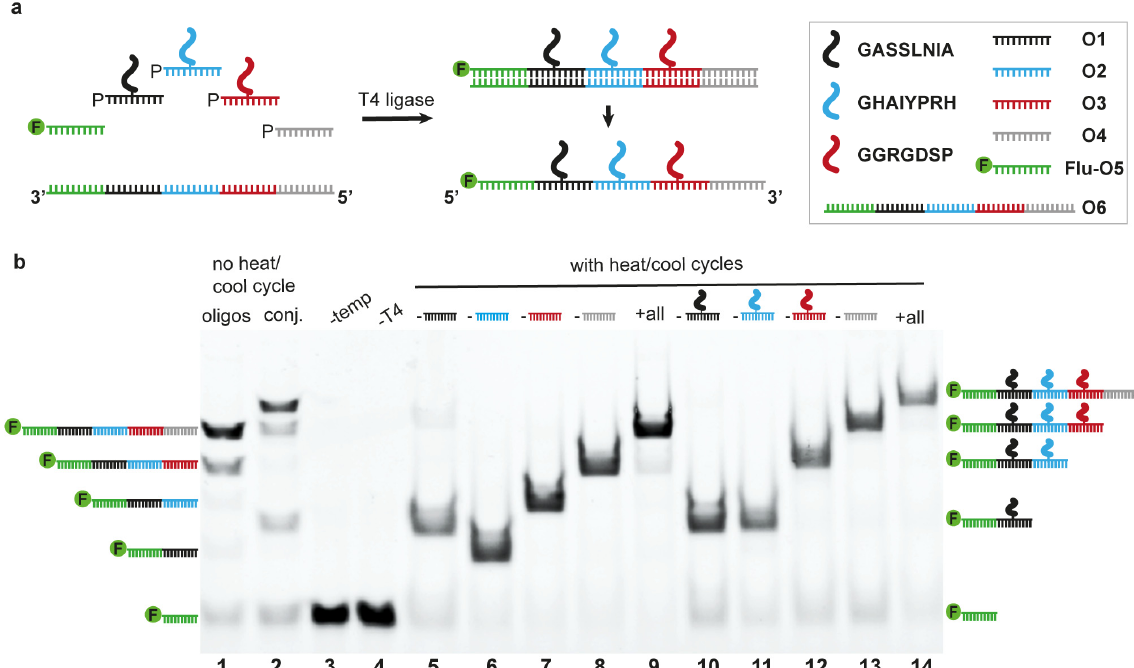
Figure 4. Templated ligation ( a ) Scheme of the ligation process: to the template ( O6 ) 5 ′ phosphory- lated oligonucleotides (or peptide–oligonucleotide conjugates) and extension sequences were added with fluorescent labelling on the 5 ′ end and ligated using T4 ligase. The ligation was carried out using 1 μ M template and three equivalent excess oligonucleotides heated to 90 °C and cooled down to room temperature before adding T4 ligase. The heat ‒ cool cycles and ligase additions were repeated three times. ( b ) Denaturing gel electrophoresis of the ligation mixtures with controls. Lanes 1–4: Ligations performed without heat ‒ cool cycles with mixtures containing non-functionalized ol- igonucleotides (Lane 1) or peptide-oligonucleotide conjugates (Lanes 2–4). For control experiment template, ( O6 , Lane 3) or T4 ligase (Lane 4) was omitted from reaction mixture. Lanes 5–9: Ligation performed using heat ‒ cool cycles with a mixture containing template ( O6 ), T4 ligase, oligonucleo- tides O1-4 and Flu-O5 . The following reagents were omitted from the mixture: Lane 5: O1 ; Lane 6: O2 ; Lane 7: O3 ; Lane 8: O4 ; and Lane 9: All reagents present. Lanes 10–14: Ligation performed using heat ‒ cool cycles with a mixture containing template ( O6 ), T4 ligase, oligonucleotide conjugates ( O1- GASSLNIA , O2-GHAIYPRH , O3-GGRGDSP) , O4 , and Flu-O5 . The following reagents were omit- ted from the mixture: Lane 10: O1-GASSLNIA ; Lane 11: O2-GHAIYPRH ; Lane 12: O3-GGRGDSP ; Lane 14: O4 ; Lane 15: All reagents present. Excluded reagents are indicated on the top of the gel and the full-length and truncated products are shown on the sides of the gel.